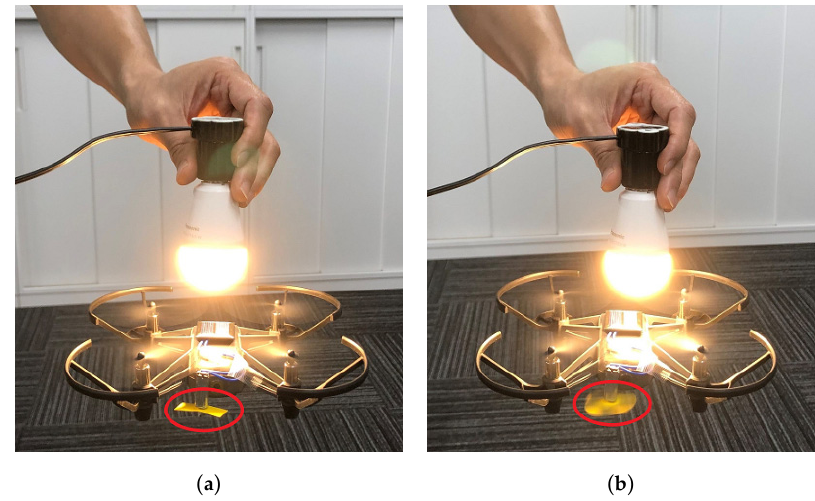
Figure 30. Experiment setup for demonstration of dynamic OWPT between a moving light source and a moving object: ( a ) no WPT; ( b ) with WPT [117].